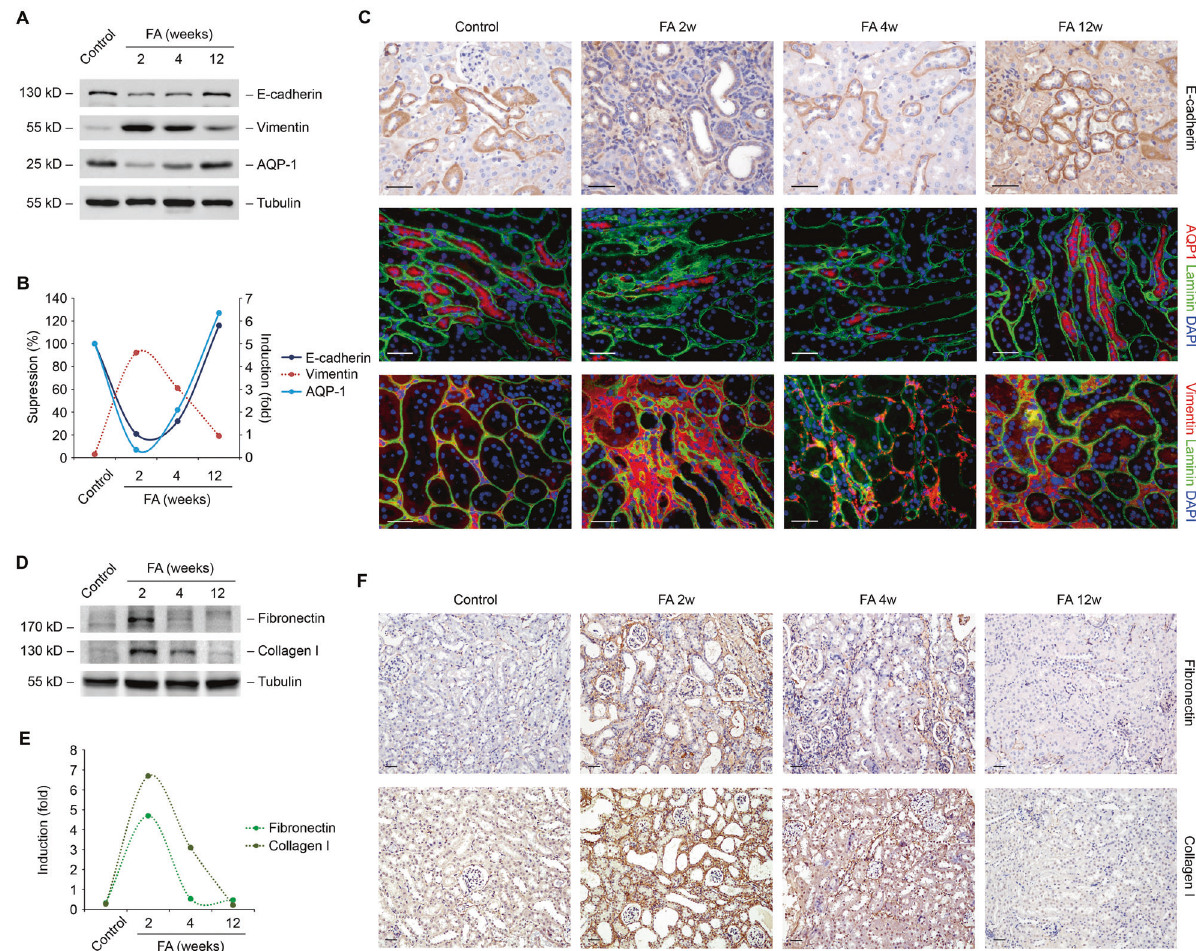
Fig. 2 Changes of tubular cell phenotype in FA model. A Western blot analysis of protein expression of E-cadherin, vimentin, and AQP-1 in kidney samples from groups as indicated. B Graphic presentation of the relative abundance of E-cadherin, vimentin, and AQP-1 in the folic acid model. C Representative images of mice kidney samples immunostained with E-cadherin, AQP-1, and vimentin. D Western blot analysis of protein expression of fi bronectin and collagen I in kidney samples from groups as indicated. E Graphic presentation of the relative abundance of fi bronectin and collagen I in the folic acid model. F Representative images of mice kidney samples immunostained with fi bronectin and collagen I. Scale bar, 50 μ